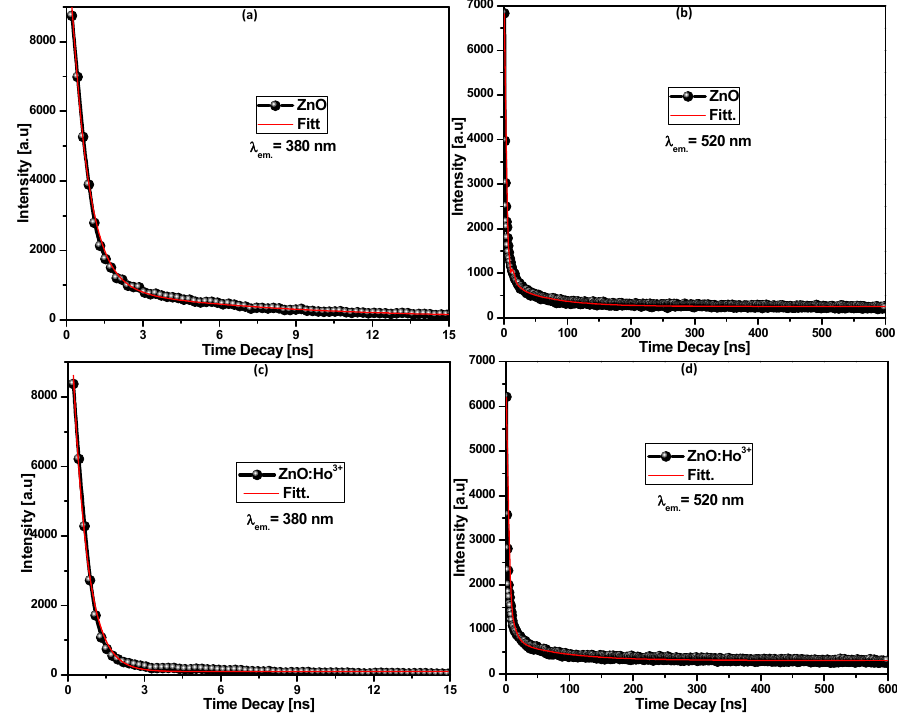
Figure 9. Exciton and defects TRPL lifetime decay of ( a , b ) ZnO and ( c , d ) ZnO:Ho 3+ (0.5 mol%) nanostructures.